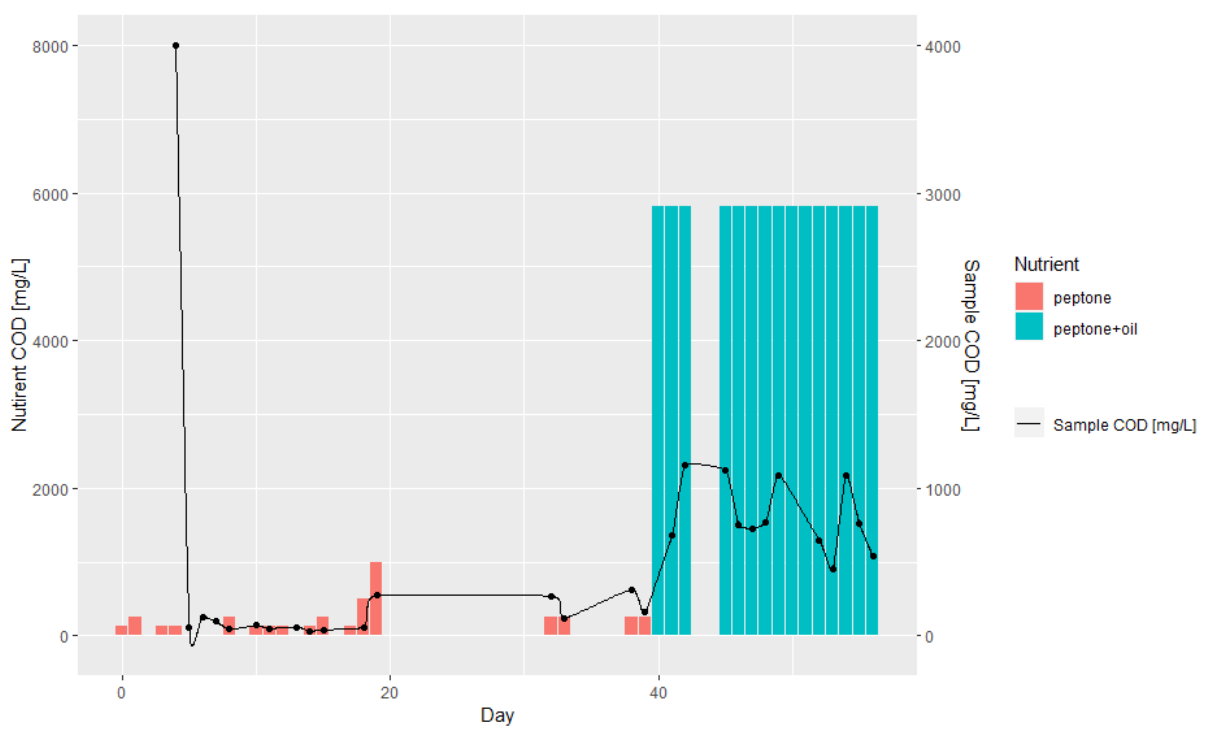
Figure 7. Relationship in time between chemical oxygen demand, nutrient medium, and filtered sample from the continuous-flow bioreactor.